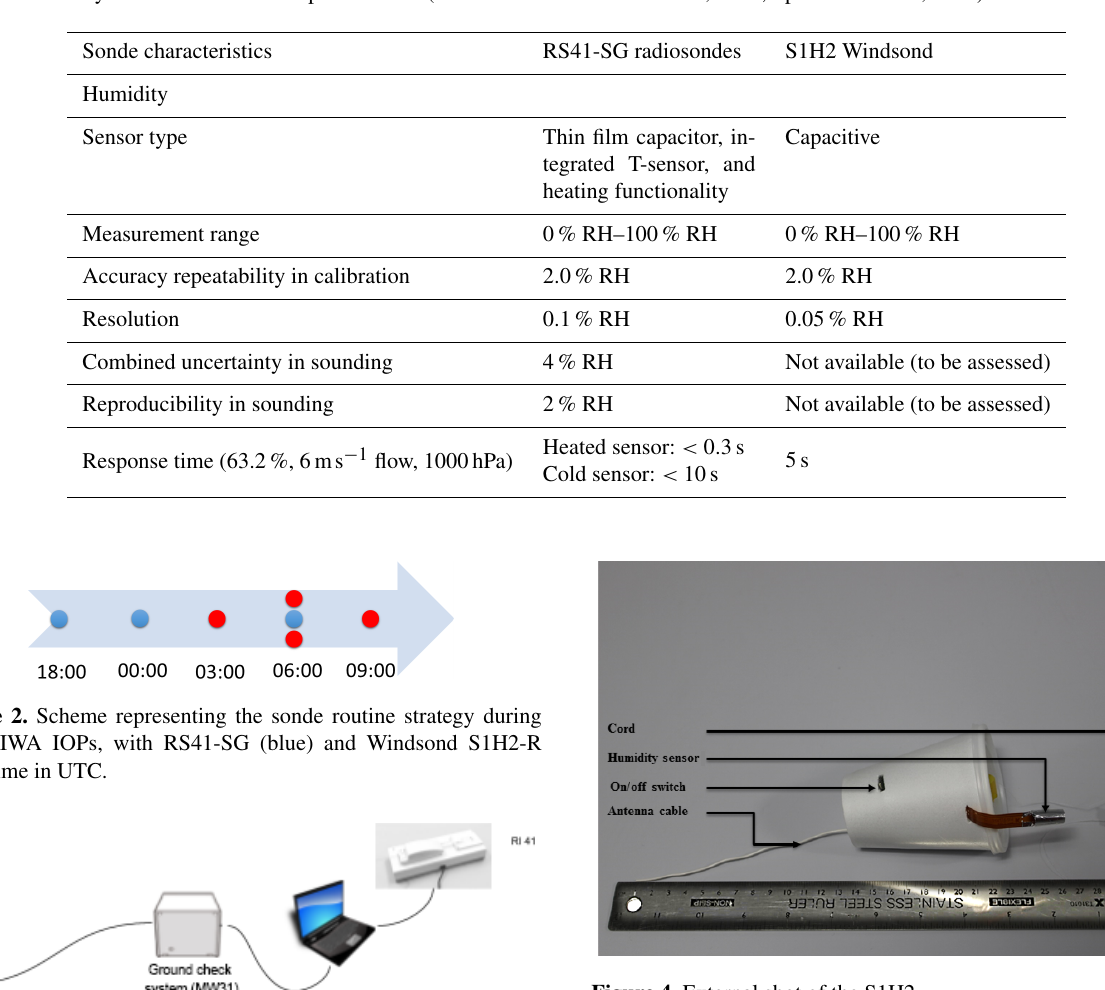
Table 3. Humidity sensor manufacturer specifications (based on Table 2 from Vaisala, 2014; SparvEmbedded, 2016).